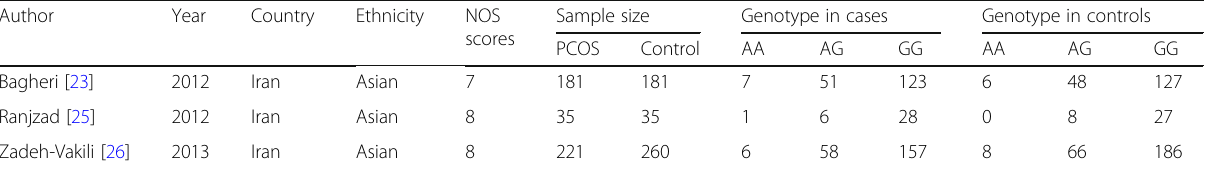
Table 5 Characteristics of studies on VDR TaqI rs757343 (G > A) variant and polycystic ovarian syndrome (PCOS)